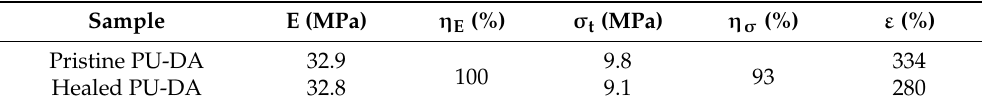
Table 2. Tensile Results of PU-DA.